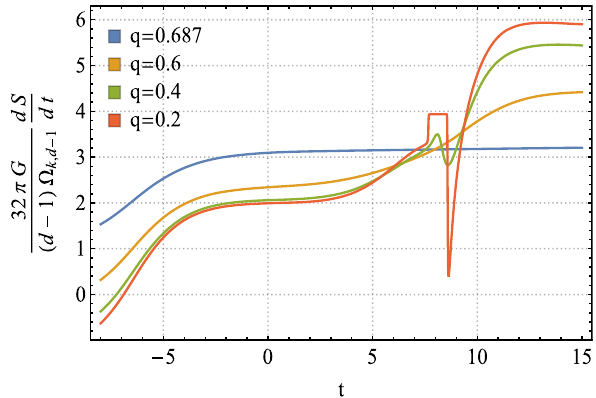
Fig. 6 The action growth rate for the heavy shock waves with the symmetric time evolution as t L = t R = t / 2, where we set d = 3 , k = 0 , l ct = 1 , L = 1 ,ω 1 = 1 ,ω 2 = 2, and t w = 5. Here q = 0 . 687 is